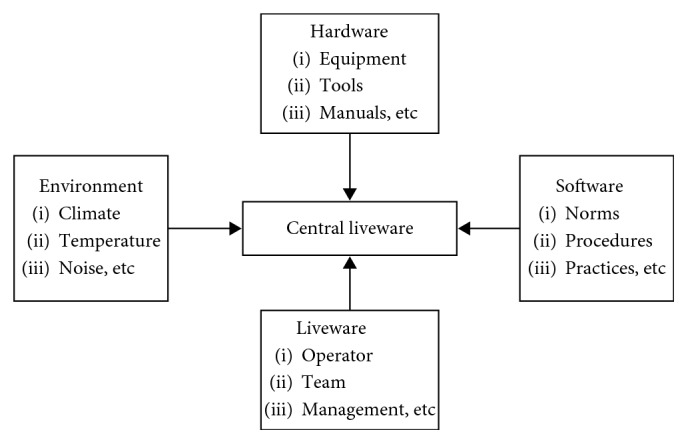
The SHELL model.